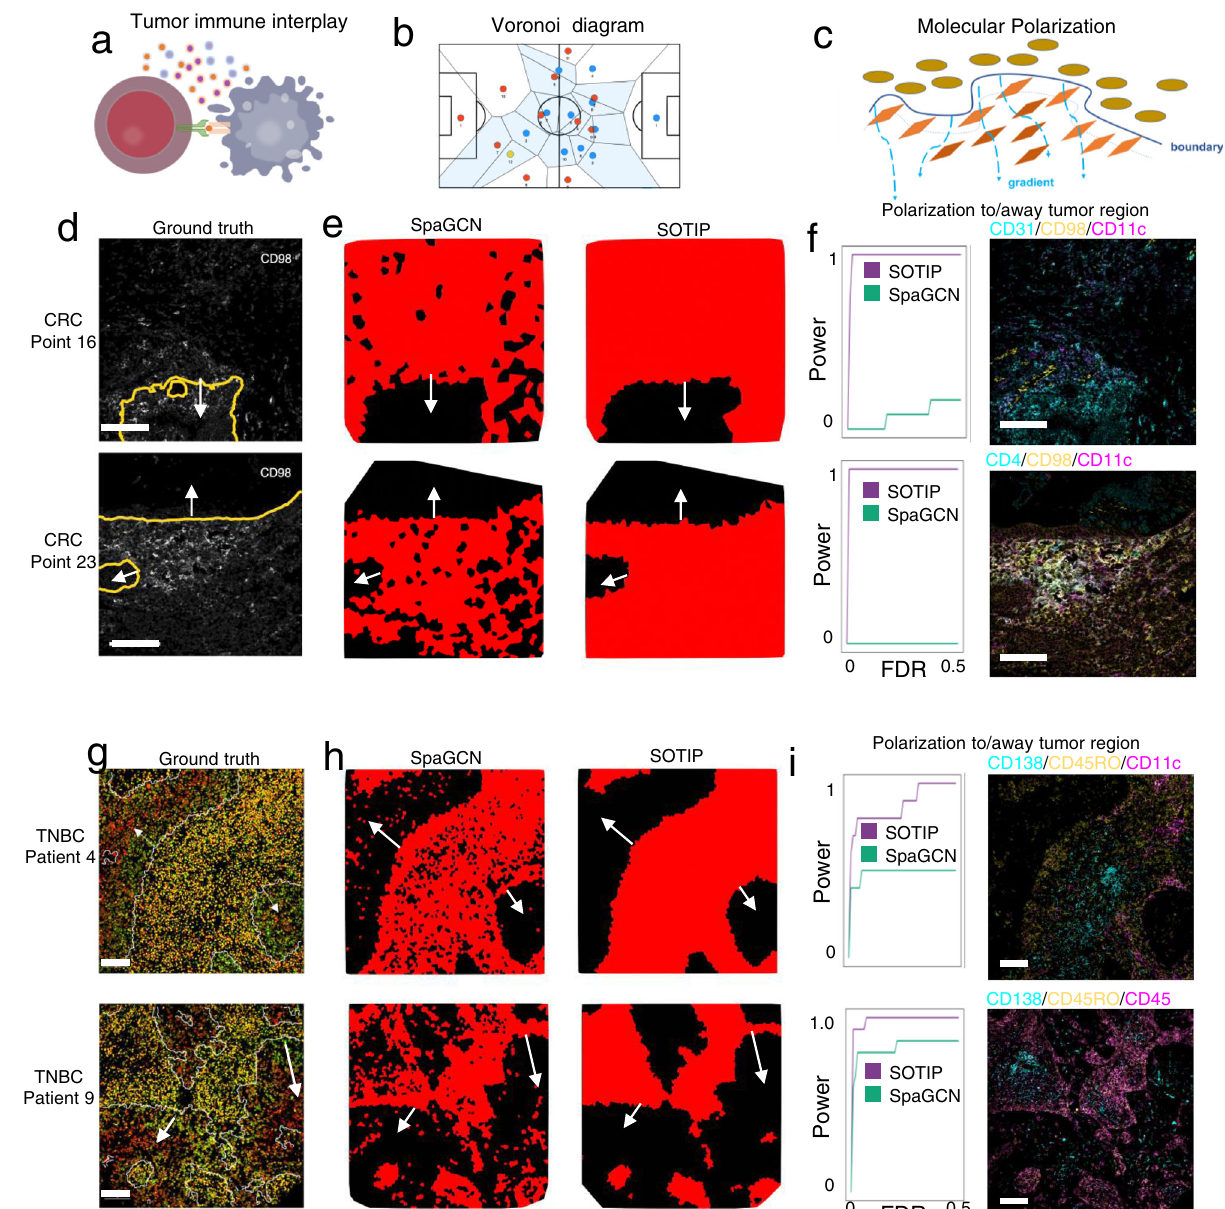
Fig. 5 | SOTIP applications on two spatial proteomics datasets. a – c Schematic diagram to show how SOTIP works spatial proteomics datasets. Illustration of tumor-immuneinterplay( a ),Voronoidiagramusedtovisualizespatialdomains( b ), and molecular polarizationto tissue boundary( c ). a Tumorand immune cells have complex interplay around the tumor-immune boundary. b Voronoi diagram (as implemented in https://stackover fl ow.com/questions/20515554/colorize-voronoi- diagram/20678647#20678647%203.18.2019) is a visualization method for spatial omics data 29 . c Molecular polarization is a phenomenon that some molecules exhibit gradient changes perpendicular to tissue boundaries. d Ground truth of tumor-immuneboundaryfromtheoriginalpaperofCRCsamples.Toppanel:point 16.Bottompanel:point23.Editedfromoriginalpaper.Scalebar:100 μ m. e Voronoi diagram of SpaGCN-detected (left column), and SOTIP-detected (right column) spatialdomains for point 16(top row)and point 23(bottom row). f Comparisonof SpaGCN-detected and SOTIP-detected spatial domains to fi nd polarized proteins